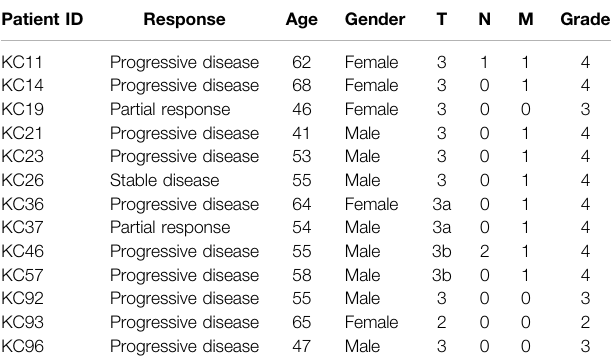
TABLE 2 | Clinical information for RCC patients pro fi led using Illumina HiSeq3000 next-generation sequencing platform in this study